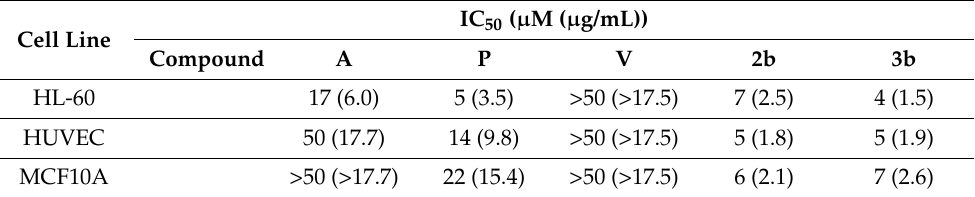
Table 3. Cytotoxic activity of selected compounds against human cell lines. Cell viability was determined by MTT assay (HL-60) and CTB assay (HUVEC, MCF10A); mean IC 50 values ( n = 3) for amorolfine hydrochloride ( A ), posaconazole ( P ), and voriconazole ( V ), and for the promising compounds 2b and 3b are